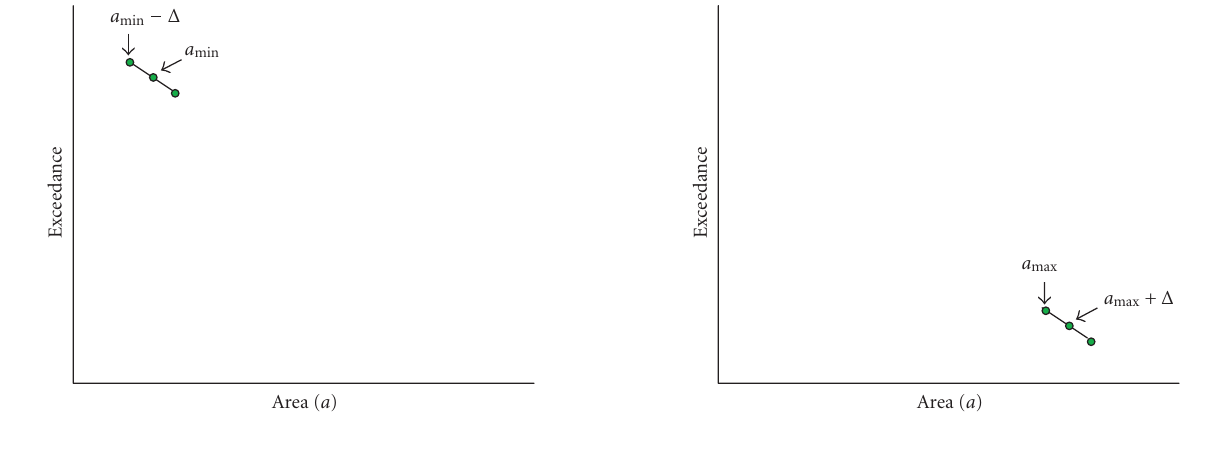
Figure 2: Illustration: perturbation of a min . Figure 3: Illustration: perturbation of a max .